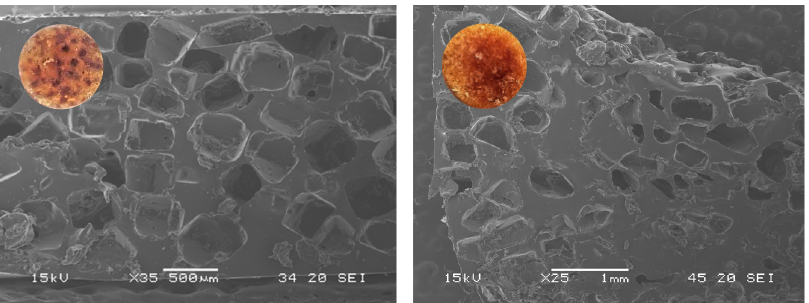
Figure 8. Scaffolds Micrographs (SEM analysis). On the left, the 2D scaffold sample and on the right, the 3D scaffold sample.